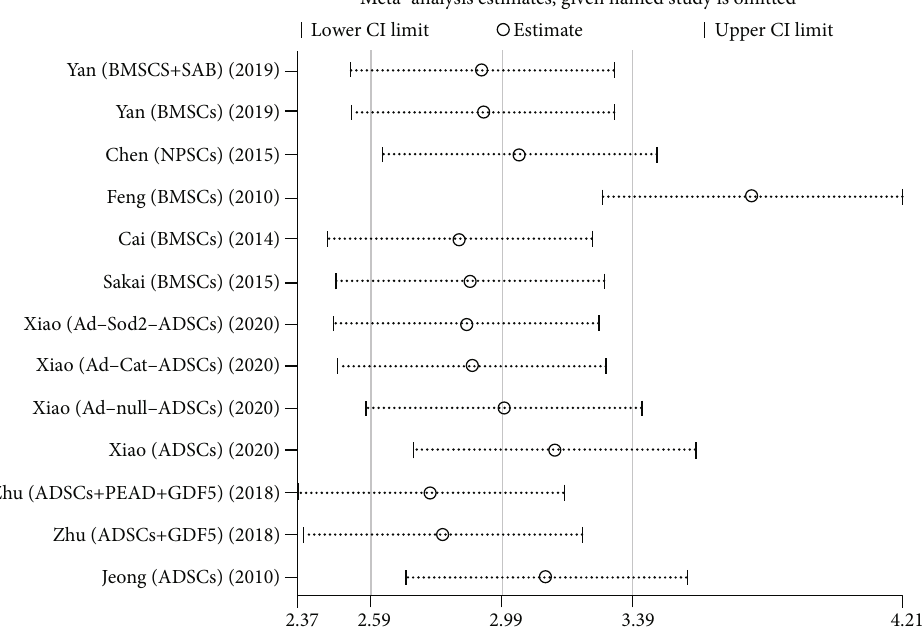
Figure 17: Sensitivity analysis of T2 signal